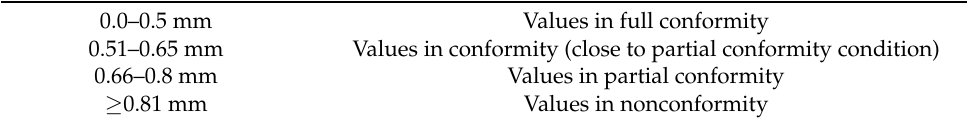
Figure 6. Molding of stands—Overall. Source: own research. Table 3. Production specification (for Figure 6). Source: own